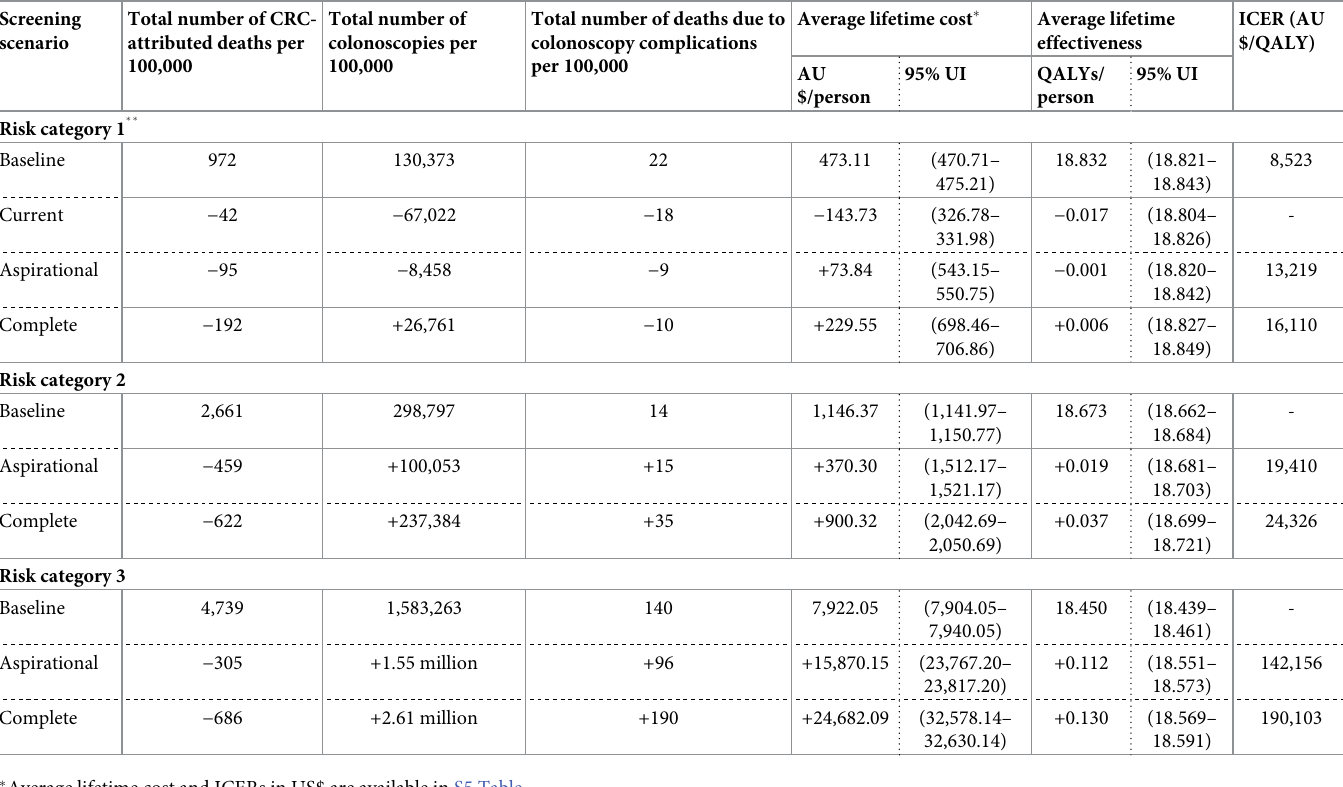
Table 3. Clinical and cost outcomes from the microsimulation for each CRC risk category. Screening